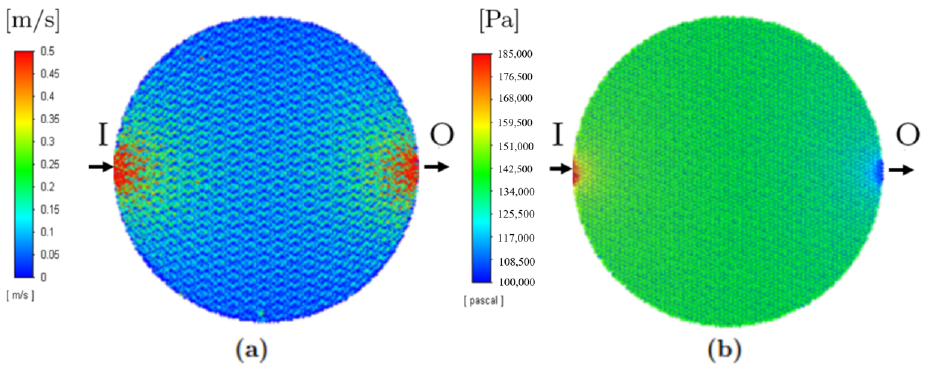
Figure 8. Distribution of ( a ) velocity and ( b ) pressure of the detailed geometry model.